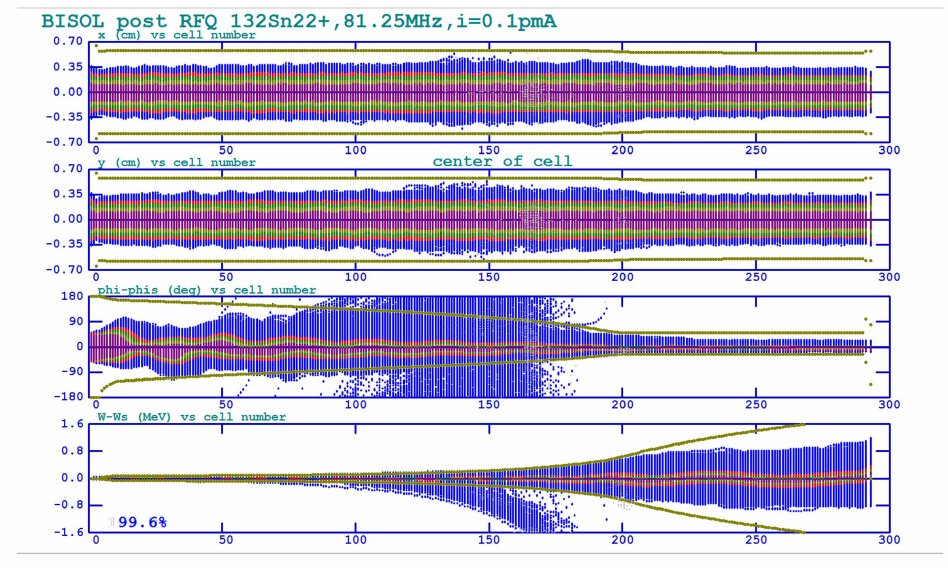
Figure 2. Beam transmission envelope of